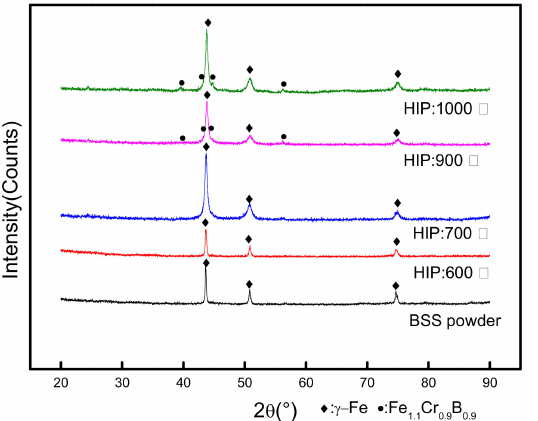
Figure 6. XRD (X-ray diffraction) of BSS (borated stainless steel) powder and alloy after HIP (hot isostatic pressing) sintering at different